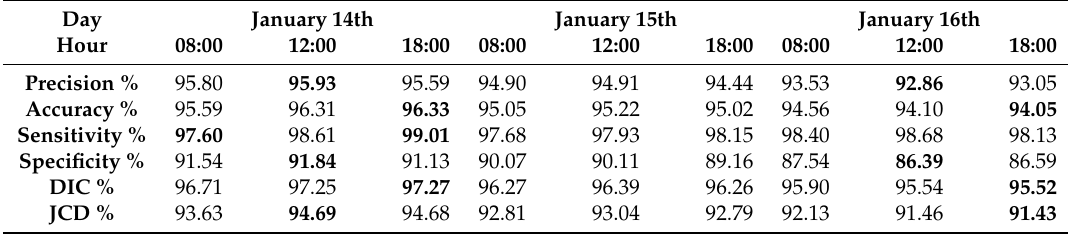
Table 5. Statistical analysis of photovoltaic module detection